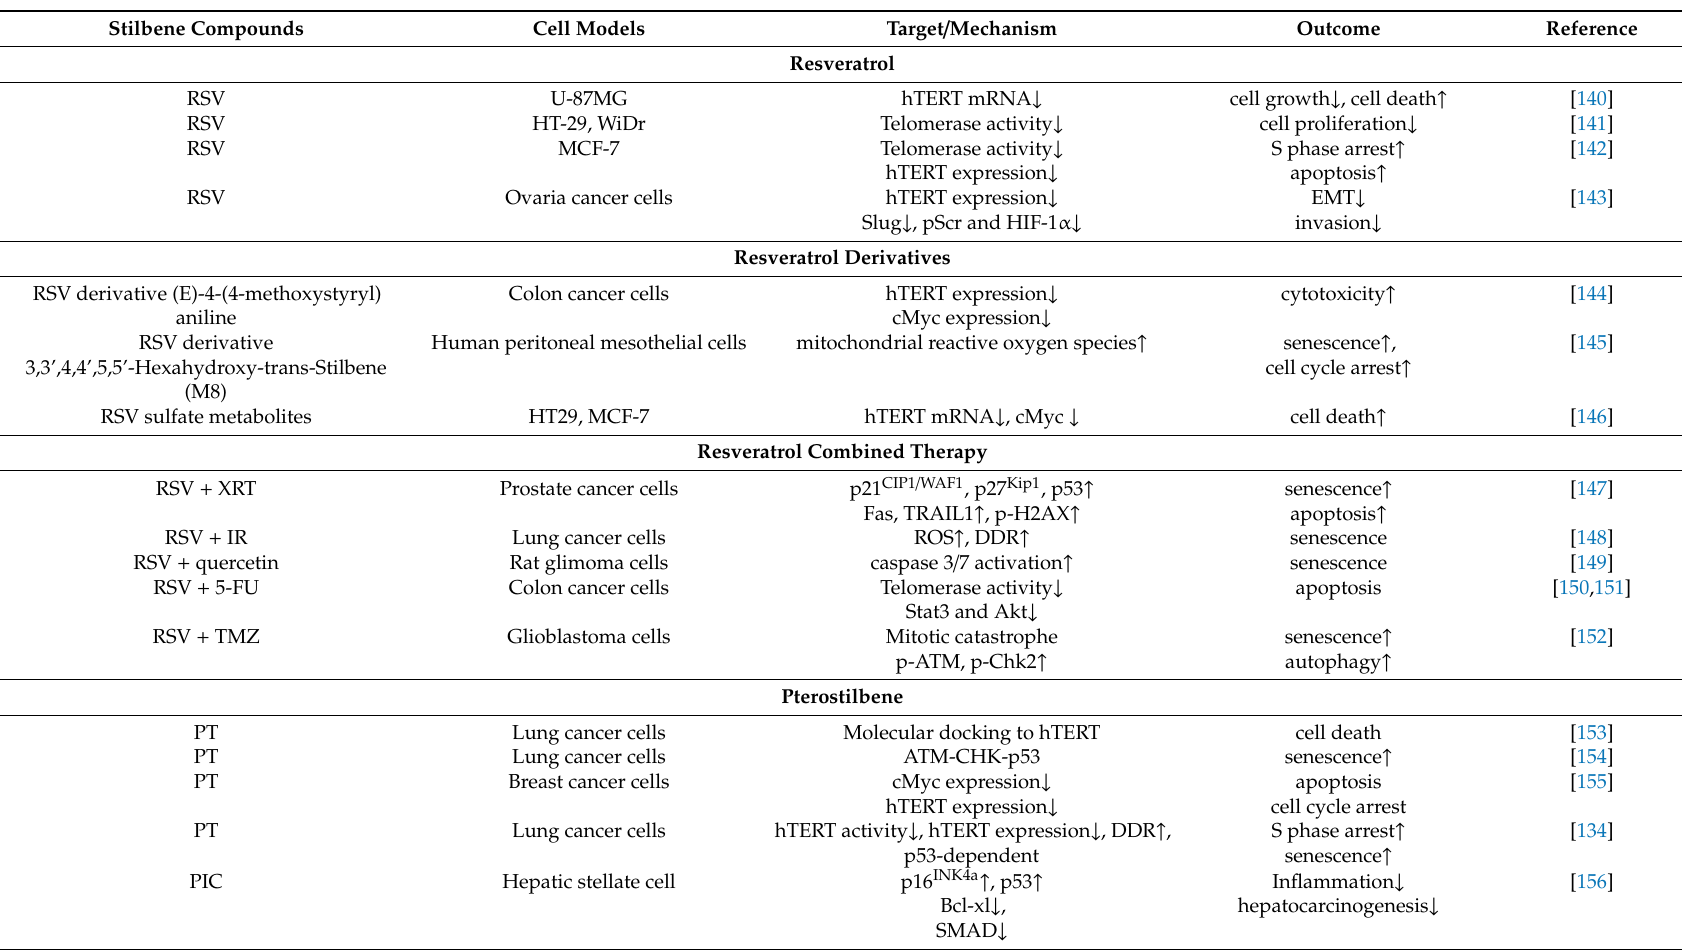
Table 1. Stilbene compounds and their anticancer mechanisms by inhibition of telomerase and induction of senescence. Stilbene